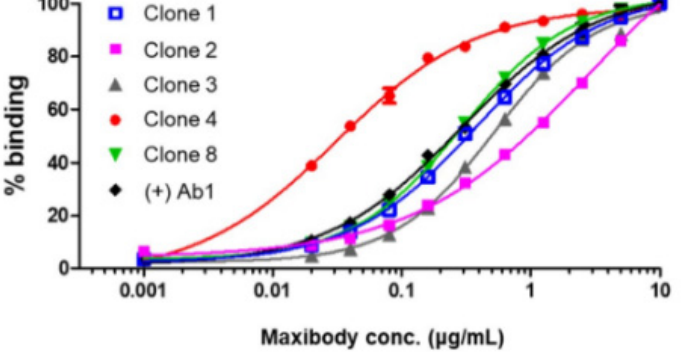
Figure 4. Binding characteristics of the maxibodies against a broad spectrum of N. gonorrhoeae . ( A ) The binding of maxibody Clones 1 and 4 are representative of the maximum cross-reactivity with diverse N. gonorrhoeae strains (upper panel). The A450 ratio of maxibody to Ab1 (left Y -axis) and maxibody to Ab2 (right Y -axis) are shown in the lower panel. ( B ) The affinity of N. gonorrhoeae maxibodies was determined by ELISA using WHO L reference strains. The N. gonorrhoeae reference strains were immobilized and incubated with serially diluted maxibodies followed by reaction with an HRP-conjugated secondary antibody. The EC 50 was calculated using GraphPad Prism. Clone 1 (Group 1); Clone 2 and 8 (Group 4); Clone 3 (Group 3); and Clone 4 (Group2).